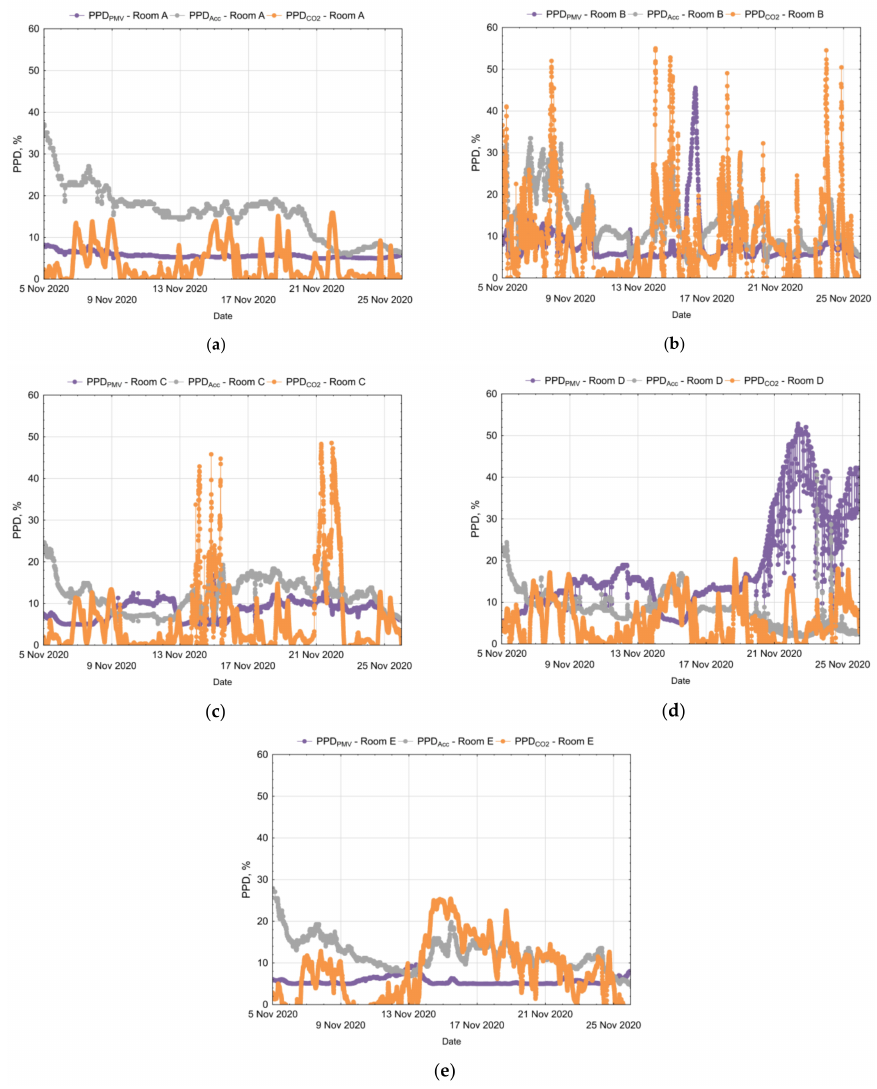
Figure 7. Variability of dissatisfaction indices calculated according to the PMV index, carbon dioxide concentration, and enthalpy relationships: ( a ) Room A; ( b ) Room B; ( c ) Room C; ( d ) Room D; and ( e ) Room